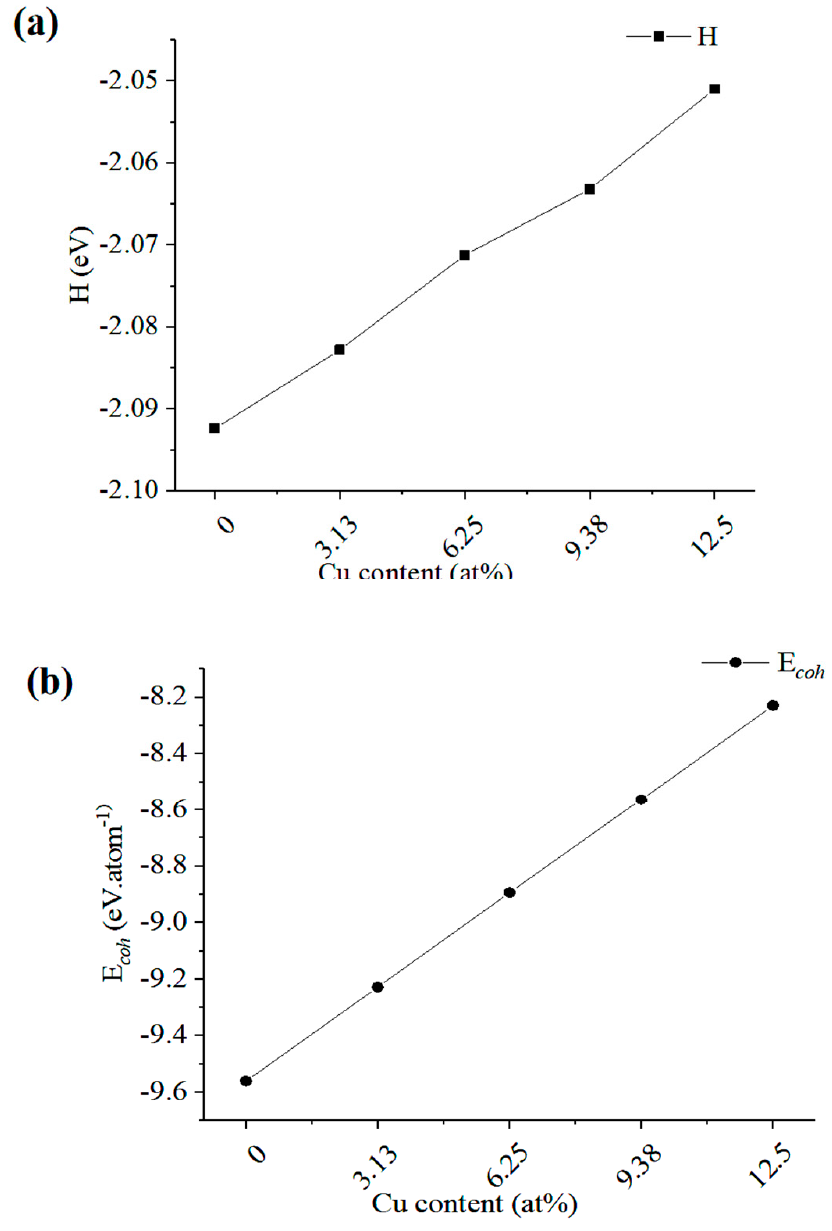
Figure 7. ( a ) Formation energy ( H ); and ( b ) binding energy ( E ) of TiCuN with different Cu con- tents.